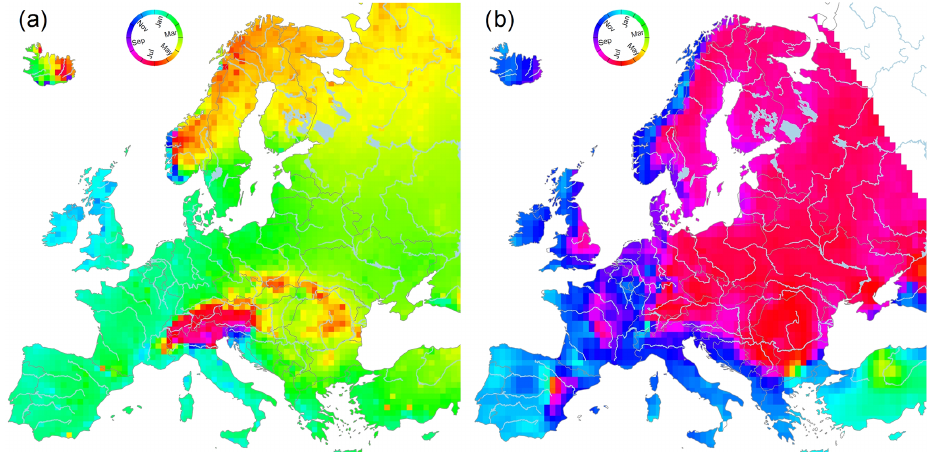
Figure 10. (a) Observed average timing of river floods in Europe based on maximum annual discharge series 1960–2020 from 4062 stream gauges. Light blue: winter floods; green to yellow: spring floods; orange to red: summer floods; purple to dark blue: autumn floods. (b) Similar maps but for 7d maximum annual precipitation based on E-OBS data. Redrawn from Blöschl et al.